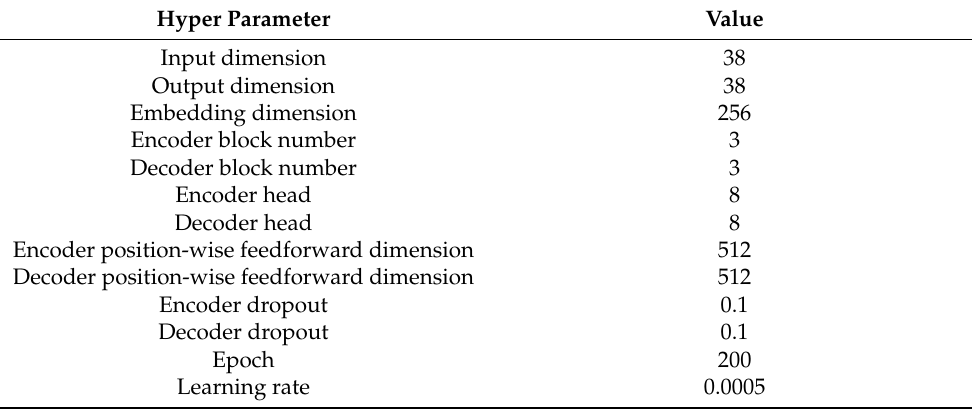
Table 3. Hyper parameters during the training phase.